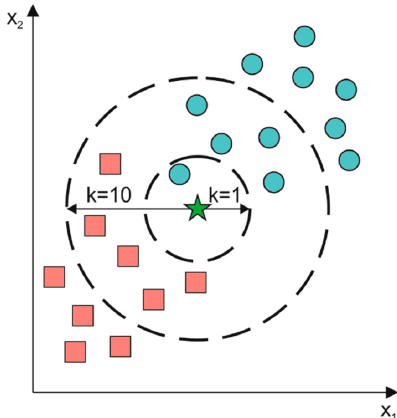
Figure 2. Example of a k-nearest neighbor (kNN) with the number of neighbors set to 1 or 10. k represents the computed distance. Circles and squares represent features related to two different classes. Star represents new data to classify.